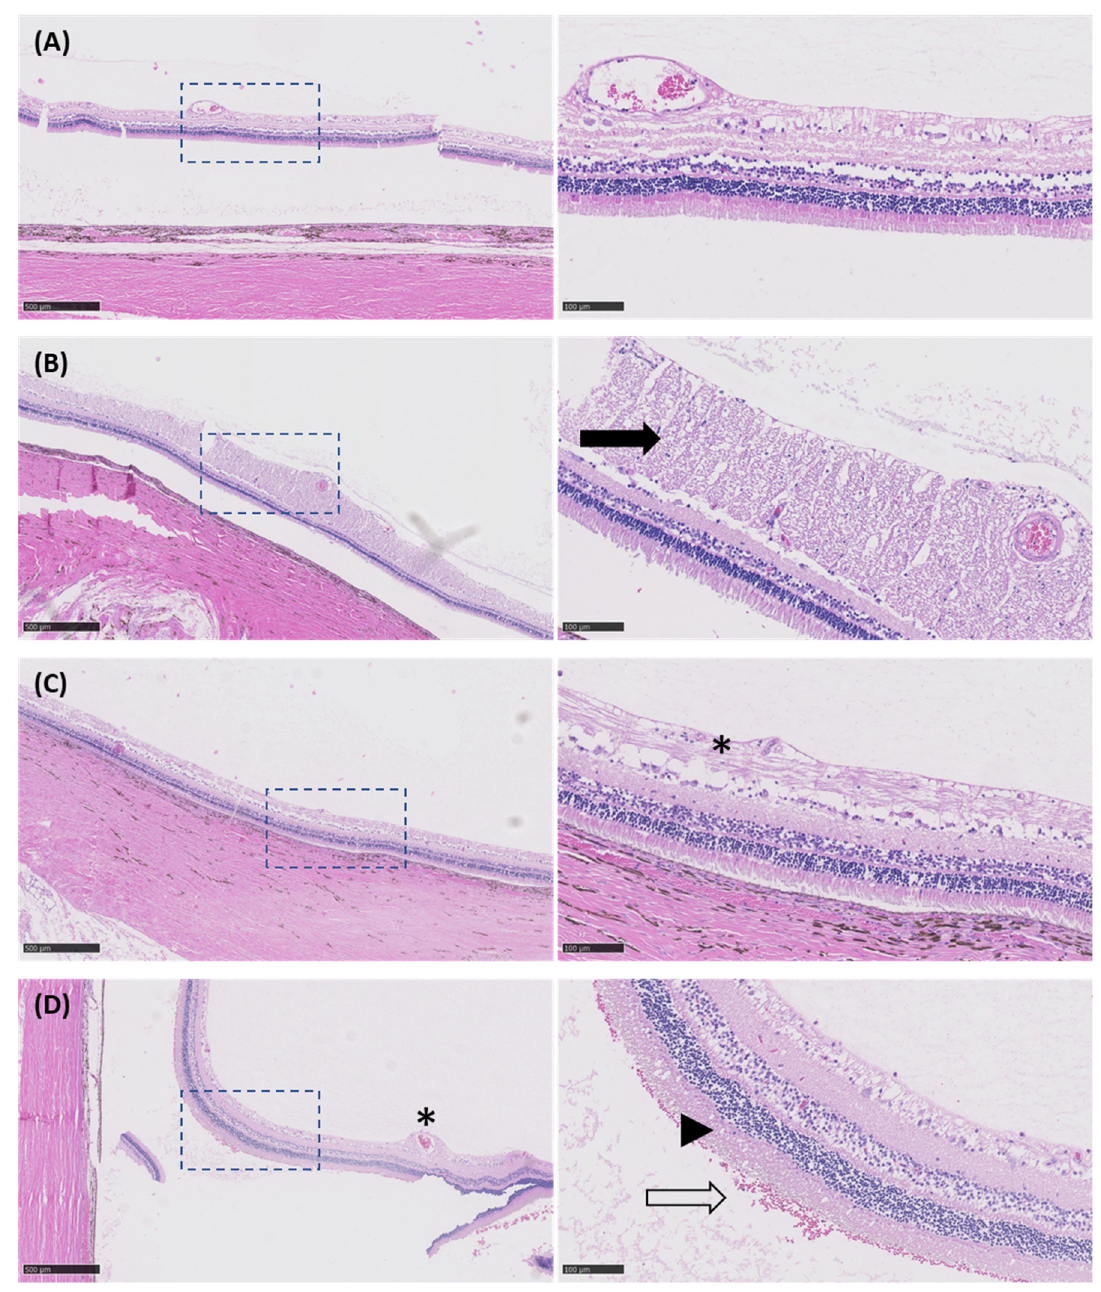
Figure 9. Microphotographs of H&E-stained sections from eyes exposed to different USMB conditions. Images on the right (20× magnification, scale bar: 100 μ m) are high magnification views of dashed-line boxes shown on the left (5× magnification, scale bar: 500 μ m). ( A ) Untreated eye (i.e., no USMB) with no signs of retinal damage. ( B ) Eye treated with USMB at MI 0.2 showing some edematous changes (black arrow) in the proximity of the optic nerve. ( C ) In the eye treated with USMB at MI 0.4, focal degenerative vacuolization with fibrinous exudate was observed (asterisk). ( D ) The most pronounced damage was seen in the eye treated with USMB at MI 0.8. Focal degenerative vacuolization with fibrinous exudate was seen around the retinal blood vessel (asterisk), erythrocytes were present in the subretinal space (hollow arrow) and loss of cell boundaries was seen in the photoreceptor layer